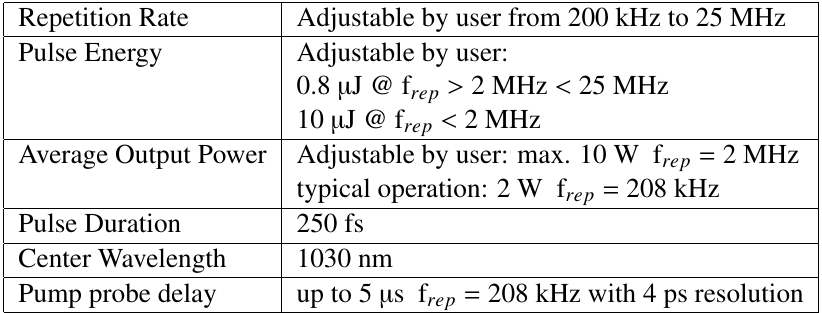
Table 1: Specification of the excitation